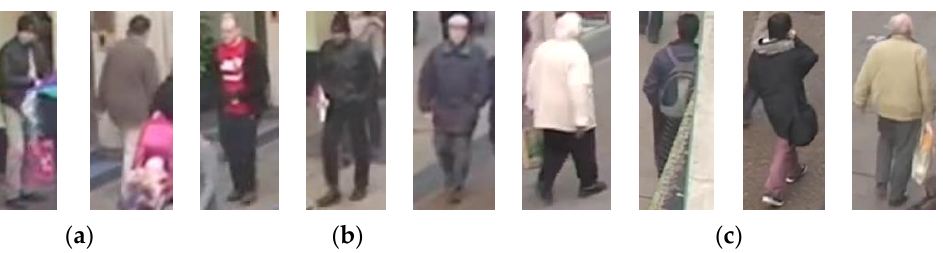
Figure 4. Examples of false-positive retrieval: ( a ) Query2, ( b ) Query4, ( c ) Query8.